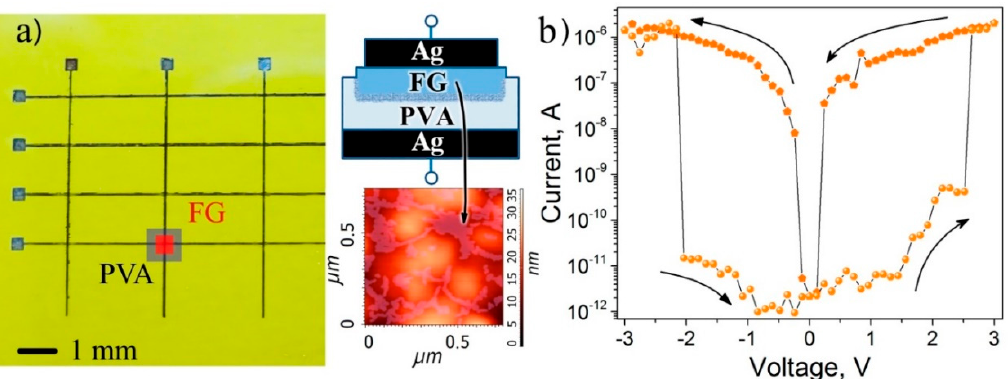
Figure 6. ( a ) The vertical crossbar Ag/ PFG/PVA /Ag structures on the polyimide (PI) substrate. The schematic cross-section of the printed structure and image of the active layer surface is shown in the insets. ( b ) The current–voltage characteristics for the printed crossbar structure measured before the deformation.